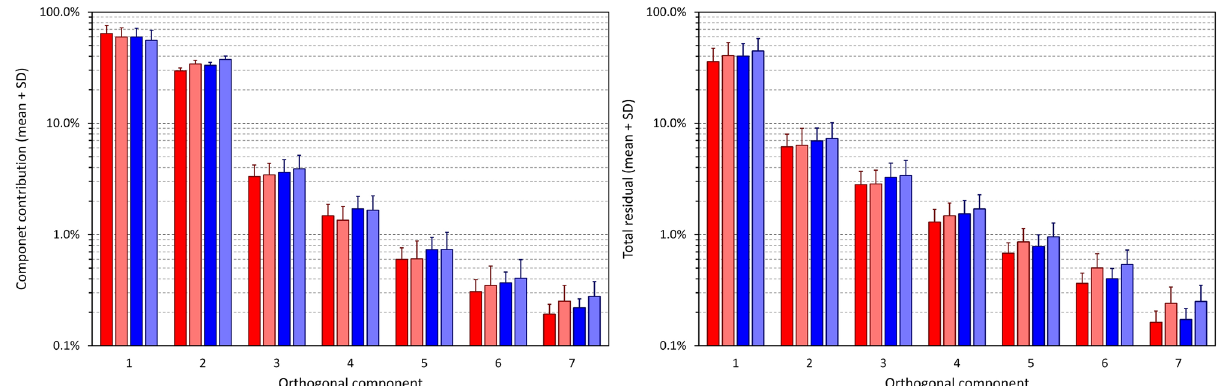
Figure 4. Summary of measured QRS components in individual study subjects. The right panel shows the contribution of individual components to the absolute QRS area, the left panel shows the proportion of the absolute QRS area remaining after the first, first + second, first + second + third, etc., component have been used to recompose the original electrocardiograms. The data in females and males are shown in red and blue, respectively, the dark and light columns correspond to the data projected to heart rates of 60 and 120 bpm, respectively. Mean values ± standard deviations are shown (note the logarithmic vertical axes). The 8th component is not shown since the combination of all 8 components covers the absolute QRS area fully and therefore, the contribution of the 8th component corresponds to the remainder after the use of the first 7